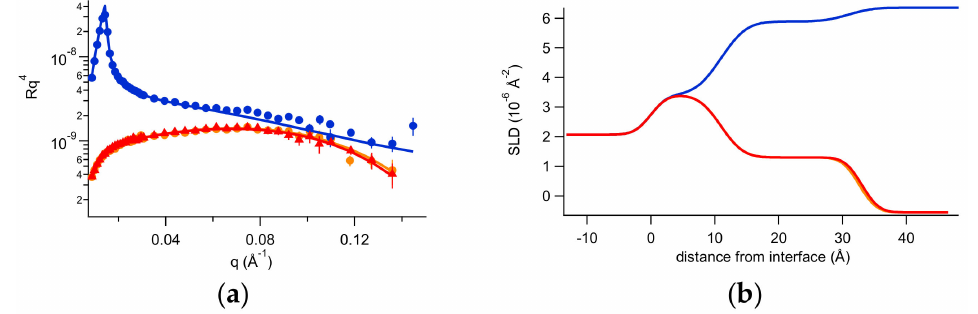
Figure 4. ( a ) Reflectivity curves (symbols), relative best fits (lines), and ( b ) obtained scattering length density (SLD) profiles of the mucin layer investigated in H2O NaCl (orange), in D2O (blue), and after the last flushing in H2O (red) at room